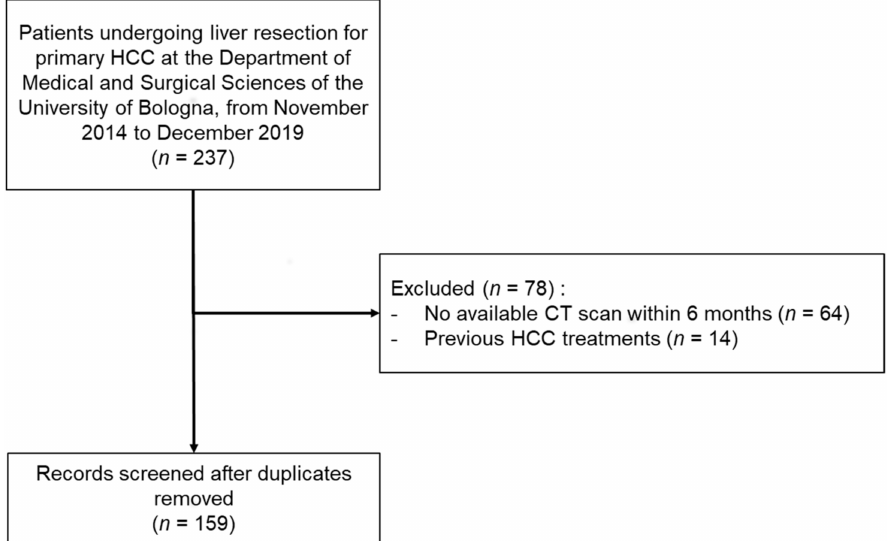
Figure 1. Flow-chart for the enrollment in the